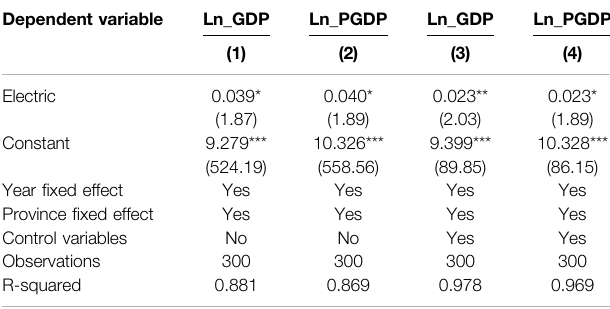
TABLE 2 | Baseline regression of the TDPR on regional economic